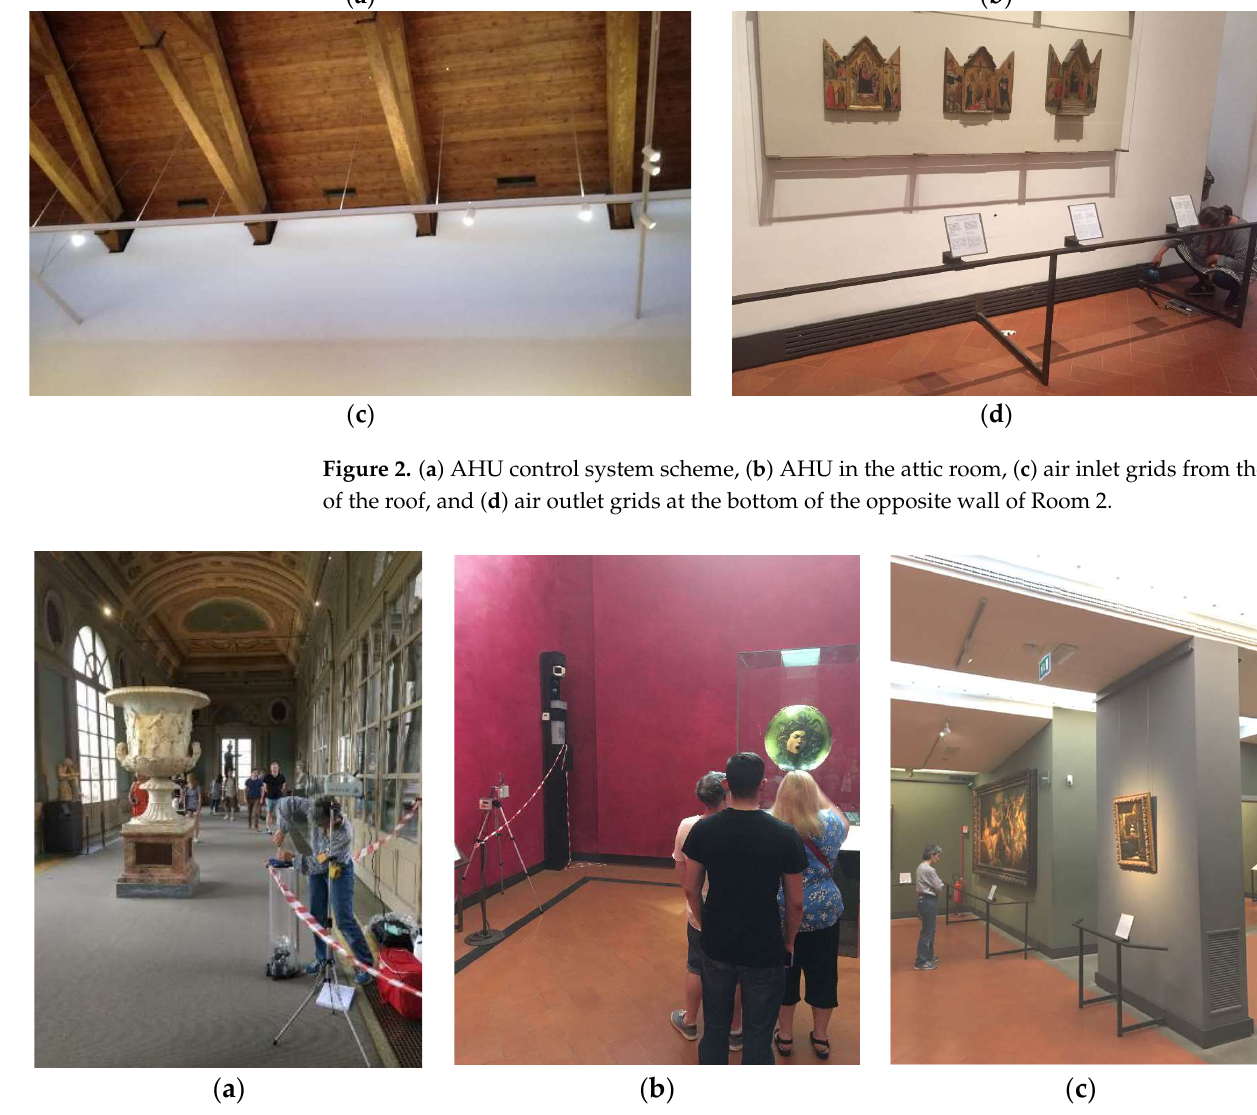
Figure 3. Analyzed rooms on the first floor of the Uffizi Gallery: ( a ) Verone I floor, ( b ) Room 41 and ( c ) Room 160.